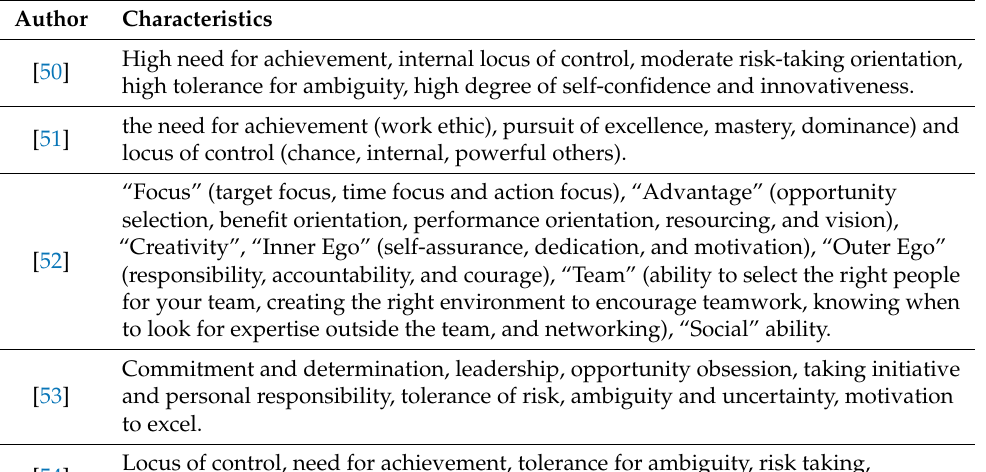
Table 1. Enterprising characteristics in empirical